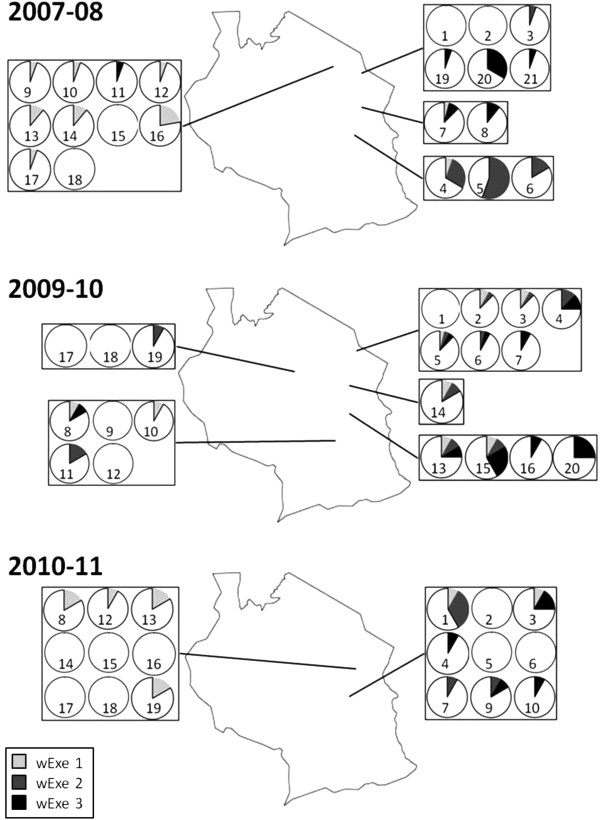
 The spatial prevalence of Wolbachia infections within armyworm larval populations sampled throughout Tanzania over the course of three field seasons. The numbers correspond to the field sites in Additional file 1: Table S1, numbered sequentially through the season.